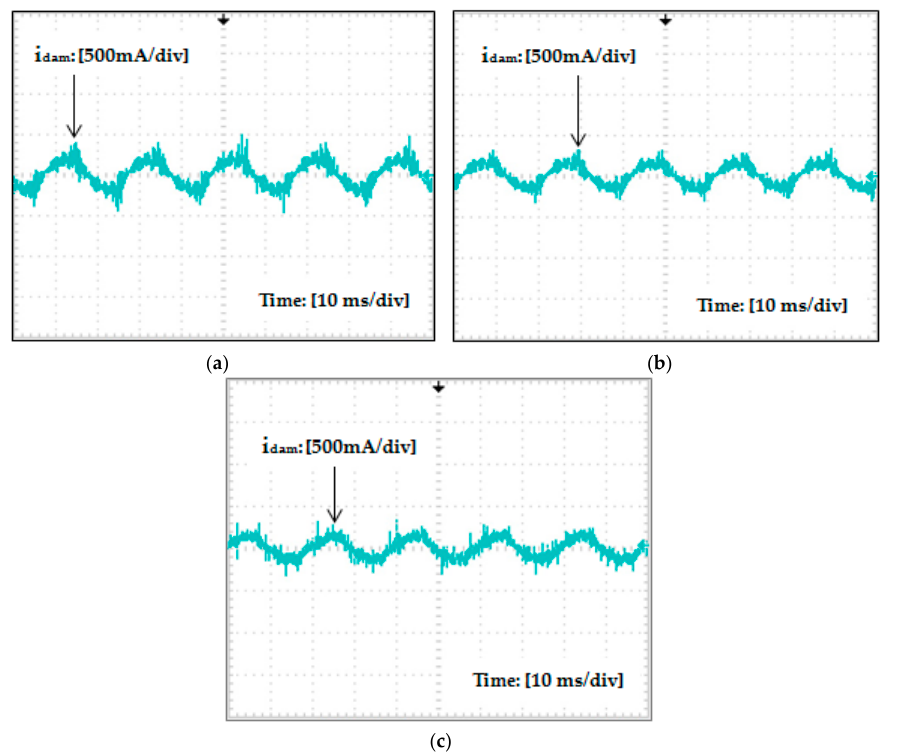
Figure 17. Experimental damping branch current waveforms with: ( a ) Filter I; ( b ) Filter II; and ( c ) Filter III.